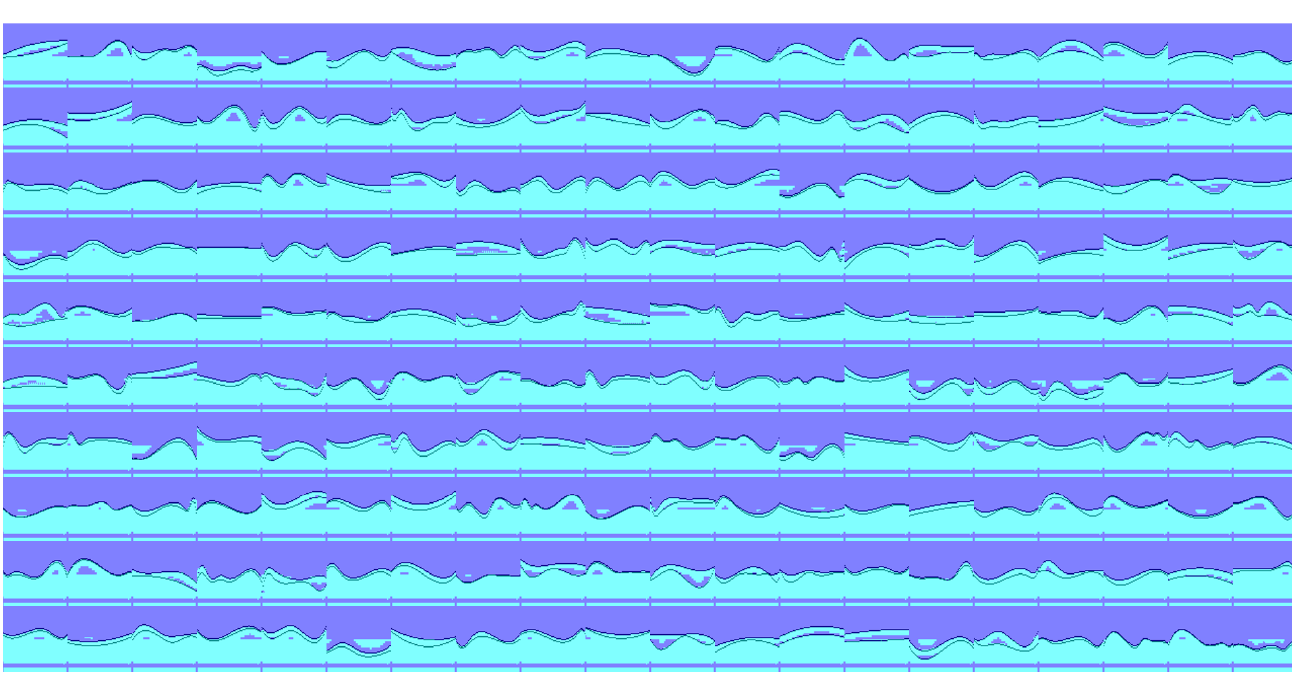
Fig. 11. SIS of the upper part. The upper border is not properly “seen”. As the empty image is segmented, a straight stripe is erroneously labelled at the